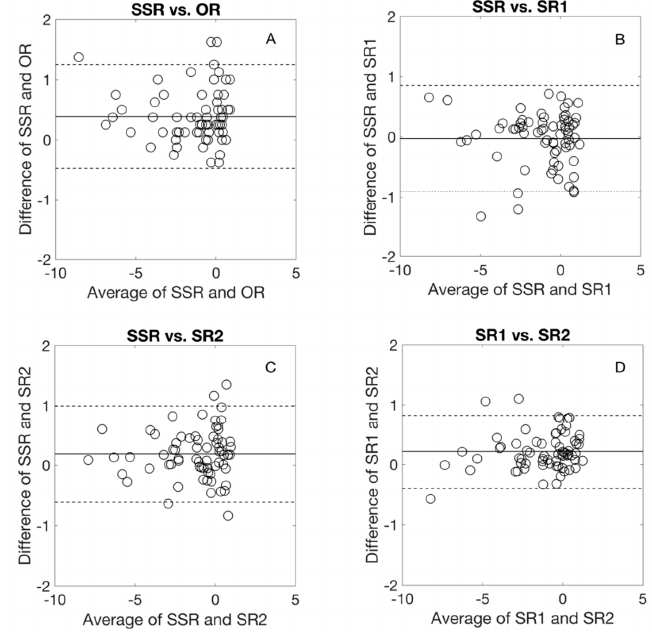
Figure 1. Bland-Altmann comparison for spherical equivalent among different refraction procedures. The middle line represents the average difference, the dashed lines represent 95% limits of agreement. OR: Objective refraction, SSR: Standard subjective refraction, SR1 and SR2: the two algorithm-based subjective refraction procedures.